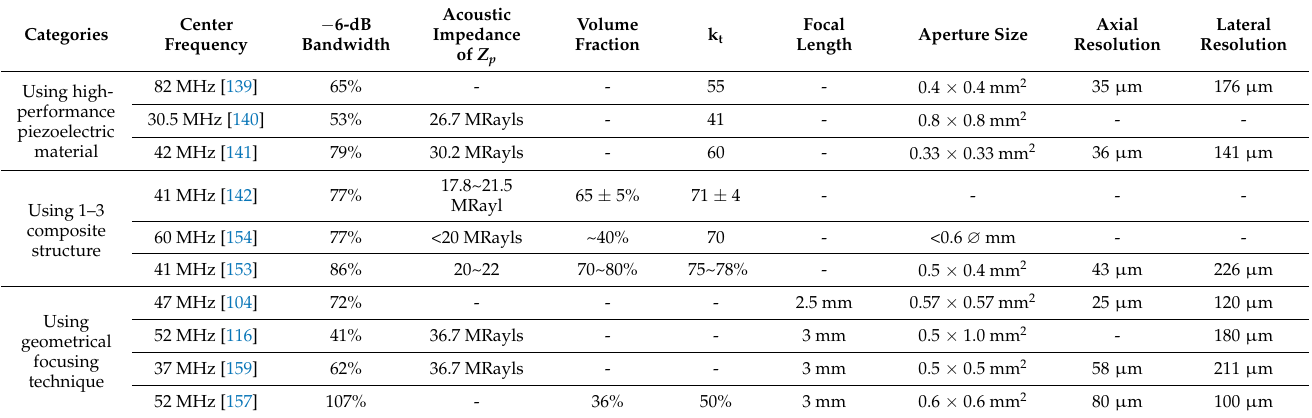
Table 2. Characteristics of single-frequency mechanical IVUS